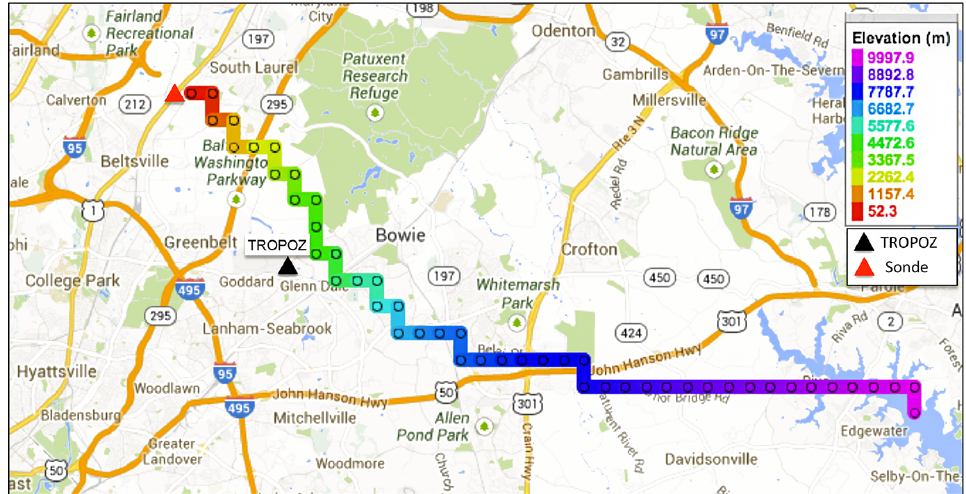
Figure 6. Ozonesonde GPS coordinates during the ozonesonde flight. The black triangle shows the location of the TROPOZ; the red triangle shows the location of the sonde launch site in Beltsville, MD; and the varying colors represent the altitude and trajectory of the sonde. When the sonde is above 7km (light and dark blue), it is 16km away from the lidar; at a altitude of 10km (magenta) it is near 30km away from the lidar. The altitude legend is on the right side of the figure. (Source: Howard University Beltsville Center for Climate Systems Observation; map source: Google Maps.)